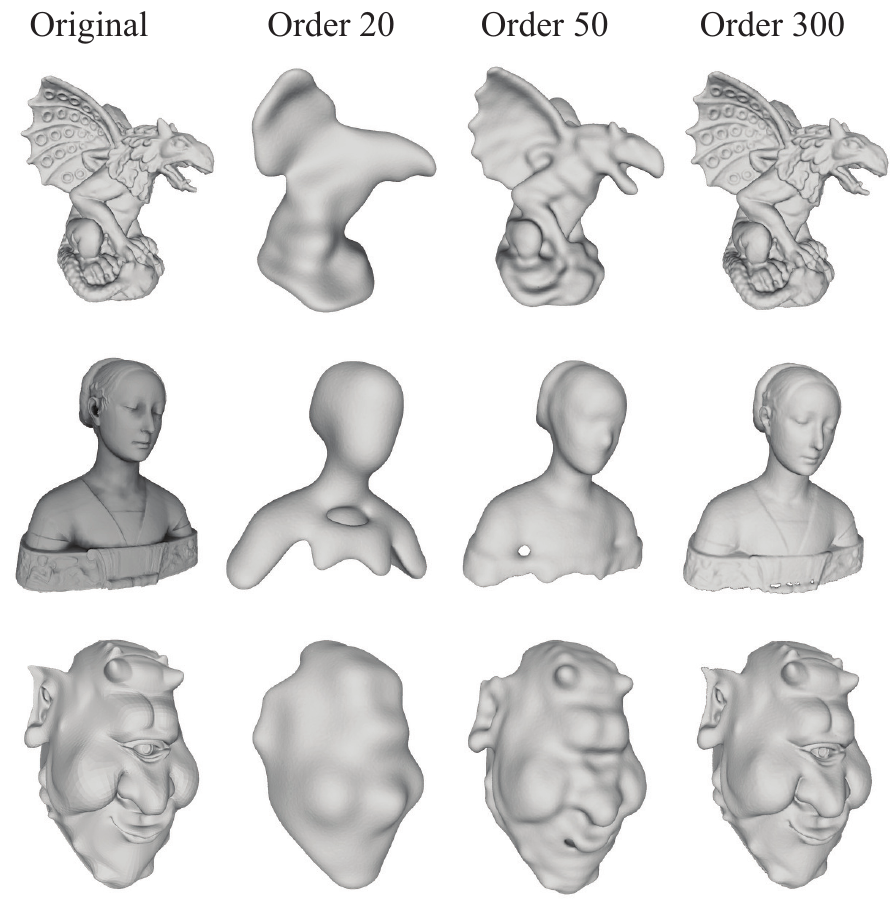
Figure 9. Reconstruction of a gargoyle ( top row ), a statue ( middle row ), and of the head of an ogre from the Zernike moments computed from a triangle mesh representing their boundaries. We compare the reconstructions generated from three different maximum order N , N = 20, N = 50, and N = 300. The original shape is shown on the left. All figures were generated with MeshLab [64]. The second row corresponds to a statue of the bust of Ippolita Sforza, sculpted by Francesco Laurana. It is available as part of the package MeshLab [64]. The mesh includes 27,861 vertices and 49,954 triangles. We computed its Zernike moments using the finite precision algorithm with a tolerance of 10 − 8 , up to order 300. We then reconstructed its shape using the same procedure described above for the gargoyle, with orders 20, 50, and 300. For N = 20, the reconstructed bust is incomplete, with no details on its surface. For N = 50, we start seeing faint features within the face, but the bottom of the bust is